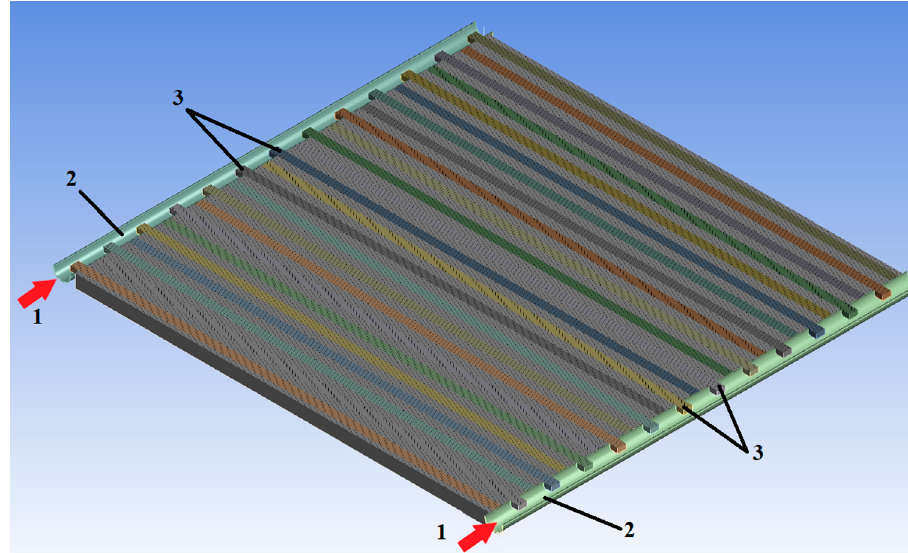
Figure 3. A horizontal section through the heat pipes and distributor. 1. Hot water inlet. 2. Distributors. 3. Rectangular heat pipes.